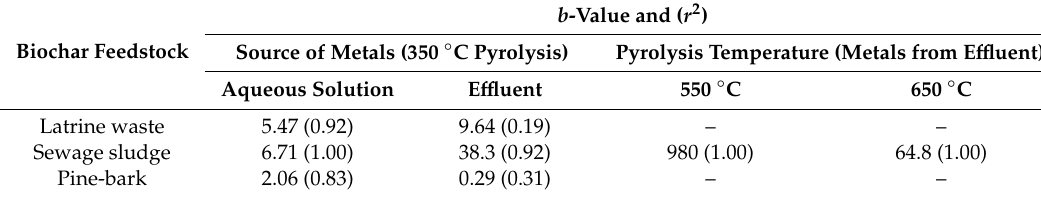
Figure 6. Maximum chromium sorption on faecal and pine-bark biochar pyrolysed at 350 °C ( a ) and on faecal biochar at increasing pyrolysis temperatures ( b ). Table 3. The b (L kg − 1 ) and r 2 values of linearized Langmuir models of chromium on biochar from latrine waste, sewage sludge and pine bark.